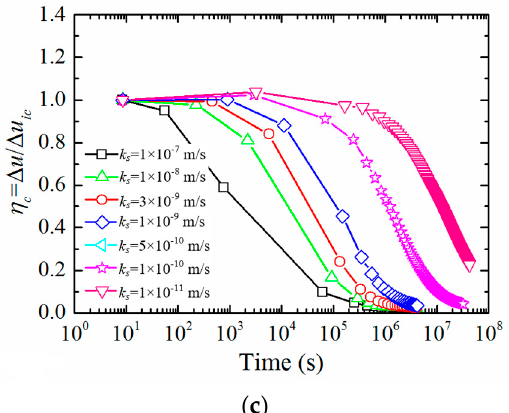
Figure 11. Normalized EPWP dissipation curves after installation under various soil permeability coefficients. ( a ) At depth of 3.0 m; ( b ) at depth of 4.9 m; ( c ) at depth of 7.5 m.